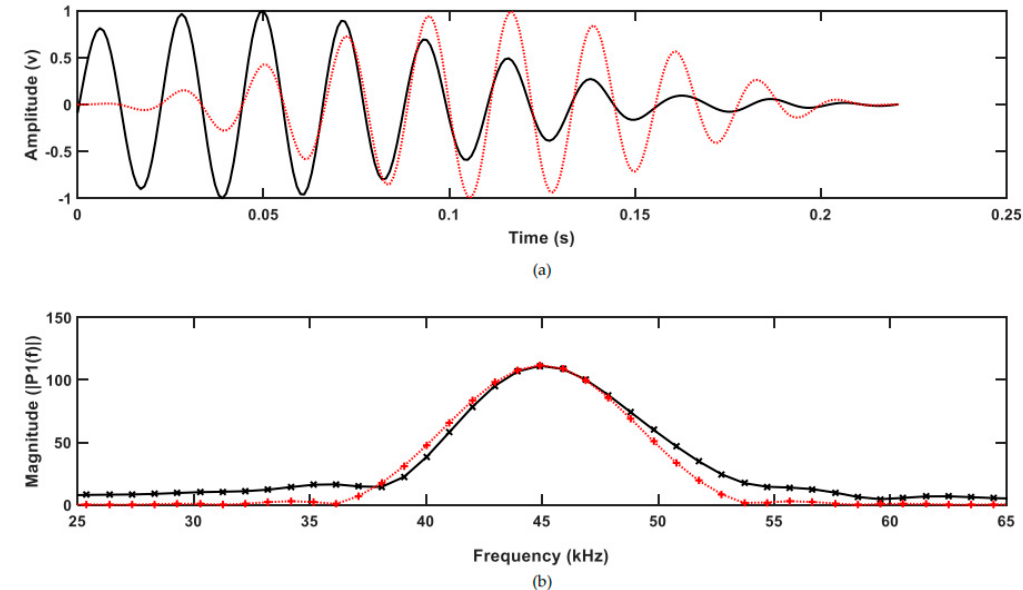
Figure 19. ( a ) The signal received from pipe end using 50 kHz and ( b ) its corresponding power spectrum. The red lines (dotted, +) show the references achieved from excitation sequence and the black lines (solid, x) show the results from each iteration.